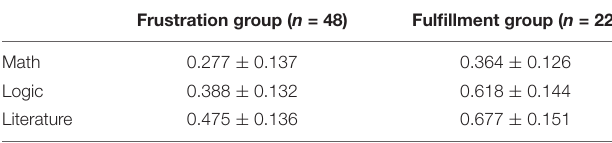
TABLE 1 | Accuracy in the “Comprehensive Cognitive Ability Test” (Mean and SD ).